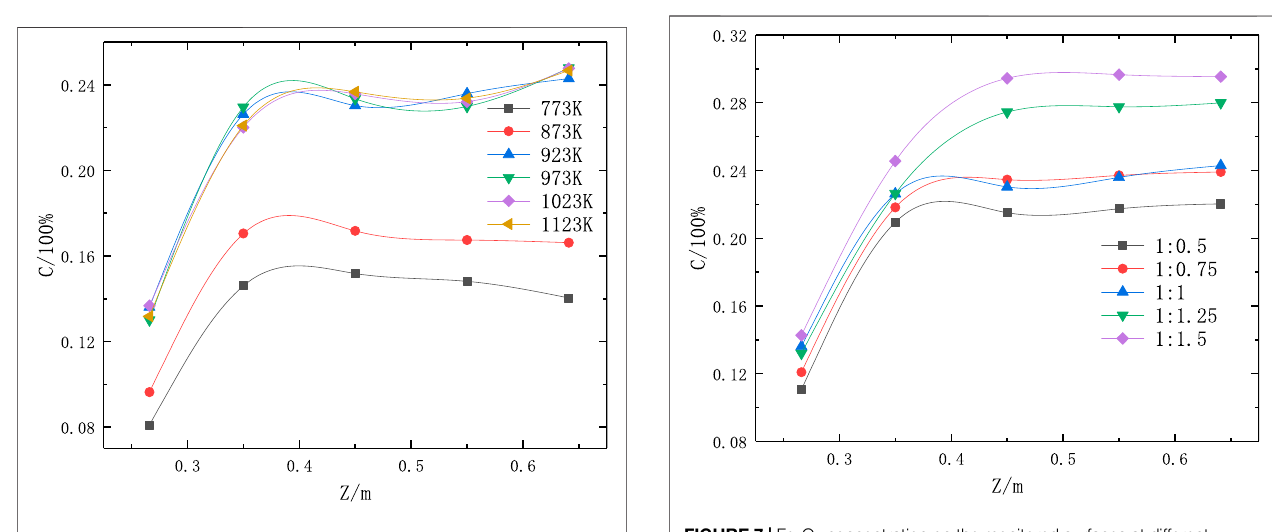
FIGURE 7 | Fe 2 O 3 concentration on the monitored surfaces at different FeCl 2 /FeCl 3